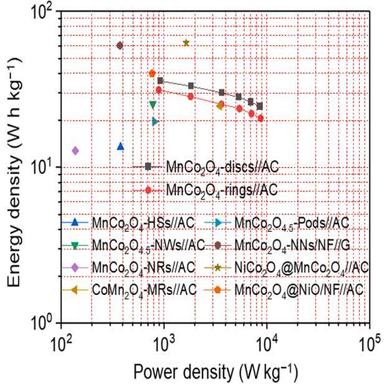
Ragone plots of MnCo2O4-discs//AC ASC, MnCo2O4-rings//AC ASC and some other previously reported ASCs assembled with MnCo-oxides as the cathode.